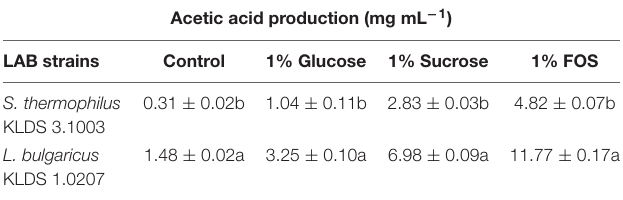
TABLE 2 | Effect of carbon source on acetic acid production of S. thermophilus KLDS 3.1003 and L. bulgaricus KLDS